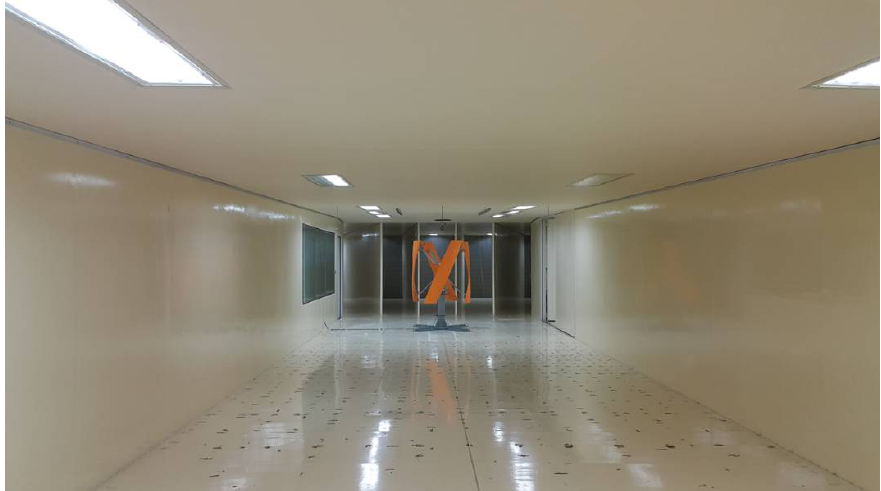
Figure 7. Wind tunnel test section.